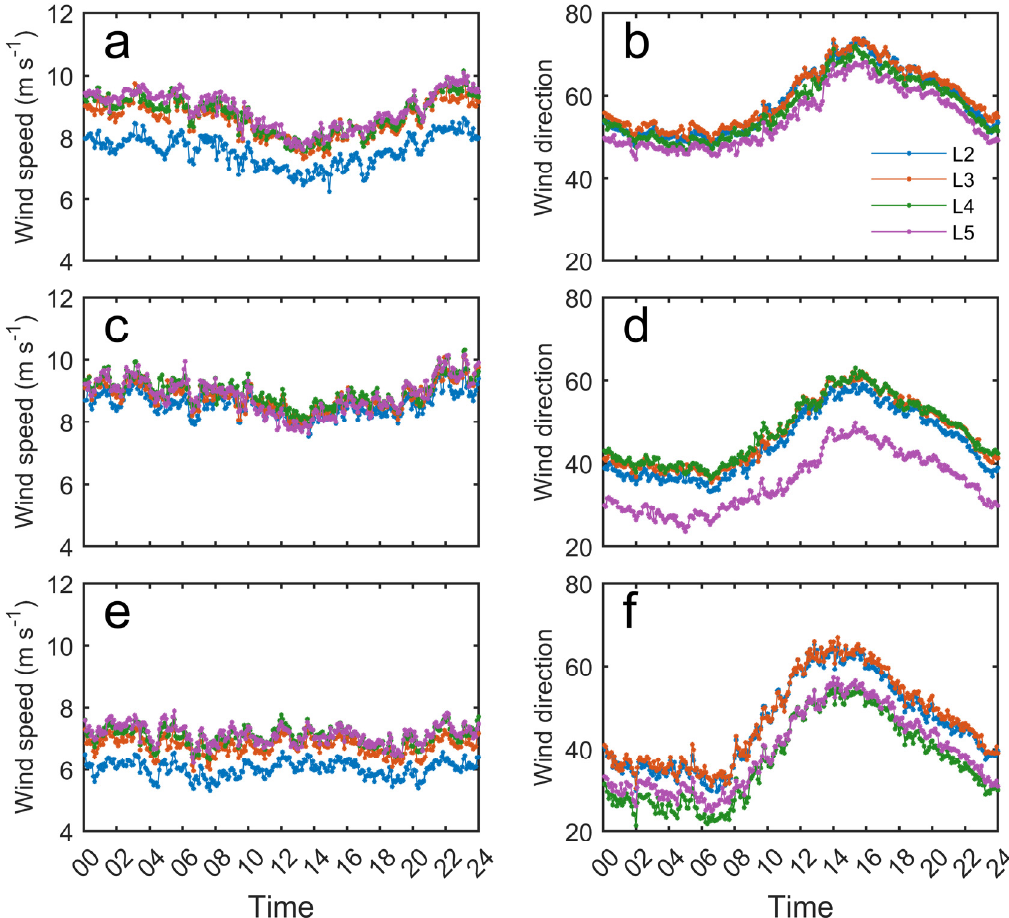
Figure 4. The diurnal variation in wind speed ( a , c , e ) and wind direction ( b , d , f ). ( a , b ): Tower 1; ( c , d ): Tower 2; ( e , f ): Tower 3. Blue line: second level; Orange line: third level; Green line: fourth level; Purple line: fi fth level.